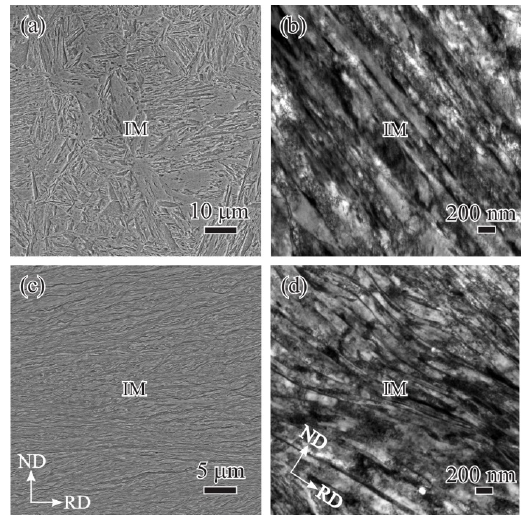
Figure 1. SEM and corresponding TEM images of tempered martensite ( a , b ) before and ( c , d ) after the cold-rolling. After holding at 755 °C for t = 90 s and then quenching, the microstructure composed of lamella ferrite regions and IM was obtained, as pointed by white and black arrows in Figure 2a. Ferrite regions contain several lamella ferrite grains parallel to the RD, as circled by the yellow dotted line in Figure 2b. Apart from the lamella ferrite, carbides precipitat- ing at ferrite boundaries could be also observed, as indicated by black arrows shown in Figure 2b. As t = 120 s, lamella ferrite regions and IM remained (Figure 2c), but the ferrite grain in t = 120 s specimens is wider than that of t = 90 s specimens by comparing Figure 2b,d. Moreover, the boundaries between the ferrite and the IM are hard to be distin- guished, and carbides could be observed inside the ferrite apart from ferrite boundaries, as indicated by the black arrows in Figure 2d. Figure 2. SEM and corresponding TEM images of quenched microstructure after inter-critical hold- ing at 755 °C for ( a , b ) 90 s and ( c , d ) 120 s.